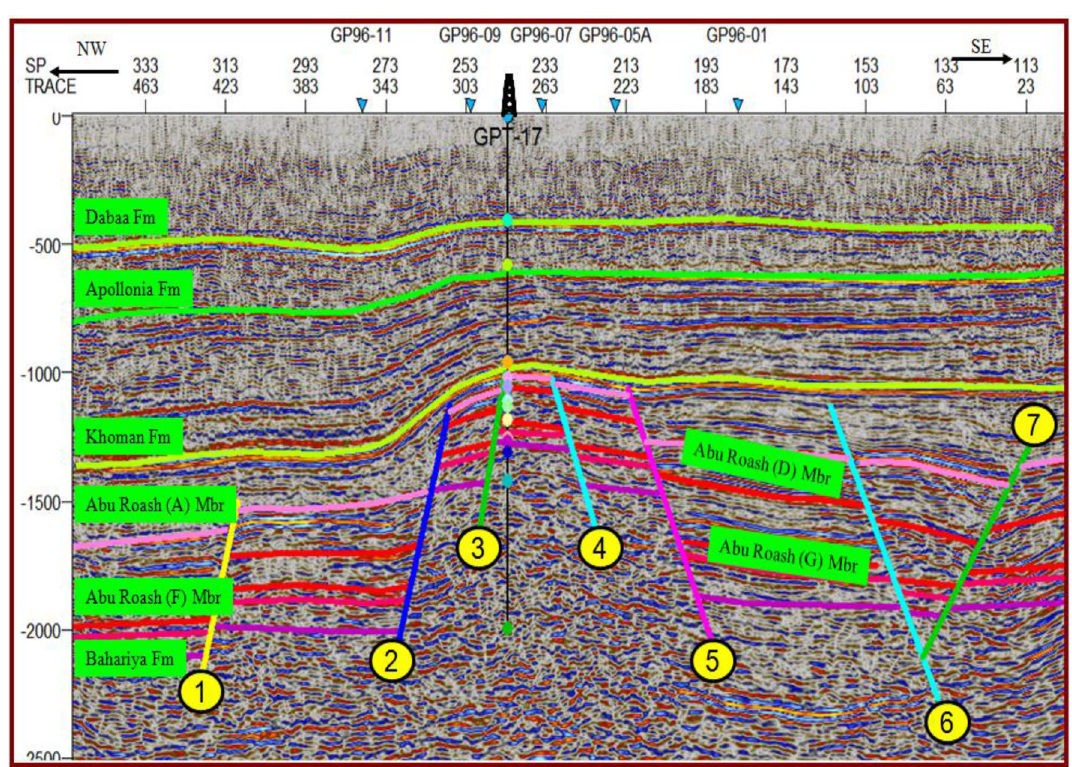
Fig. 5 NW–SE interpreted seismic section